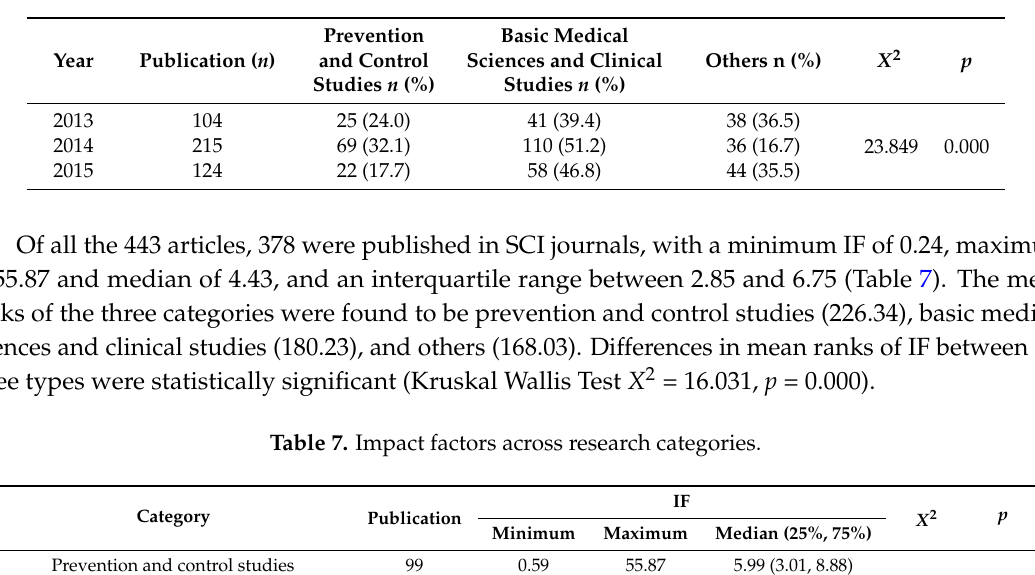
Table 6. Research categories across years ( n = 443).